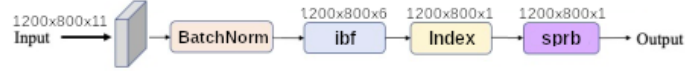
Figure 11. Network synthesis with ibf , evalated index equation , and sprb .